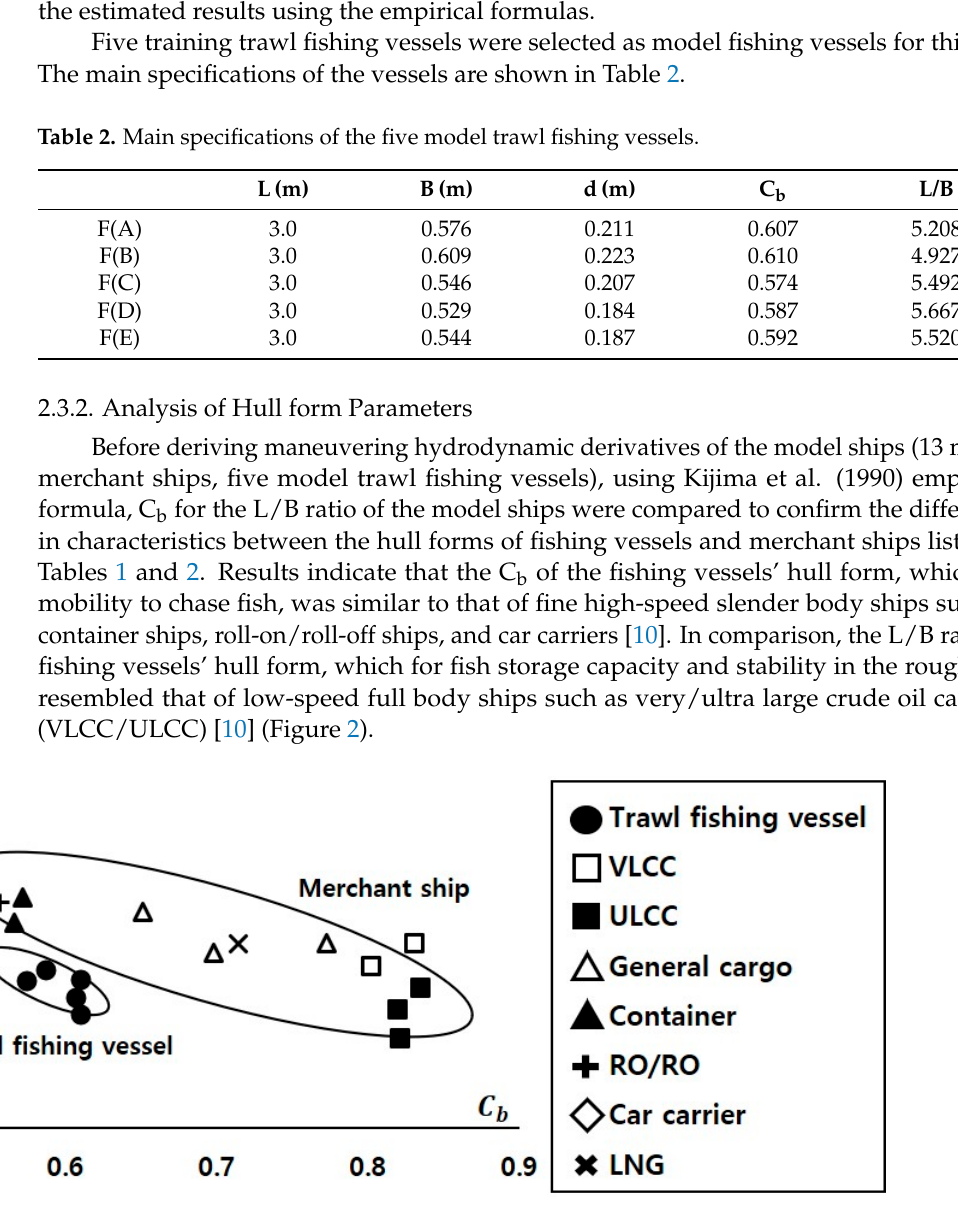
Figure 2. Relationship between C b and L/B of the model